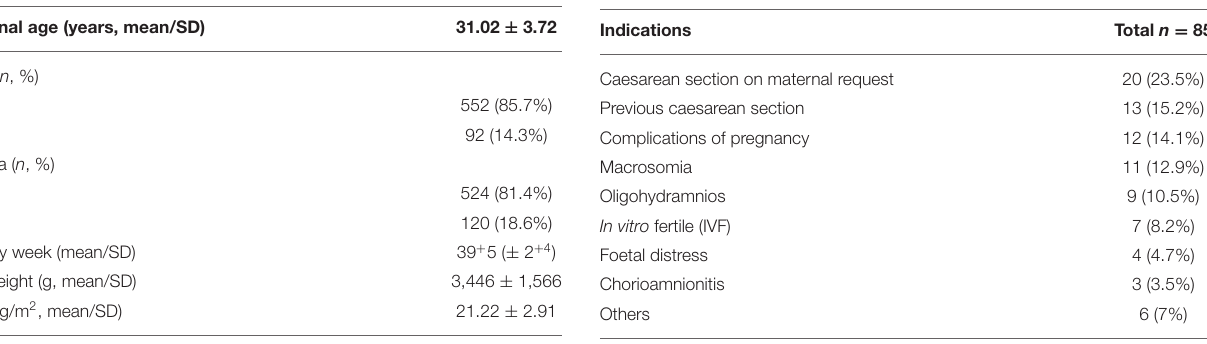
TABLE 3 | Indications for planned caesarean section in pregnant women who attended to a pre-natal education course.